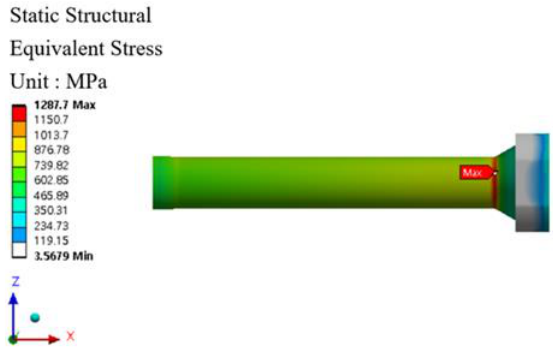
Figure 29. Von-mises stress of stem at 400 °C.